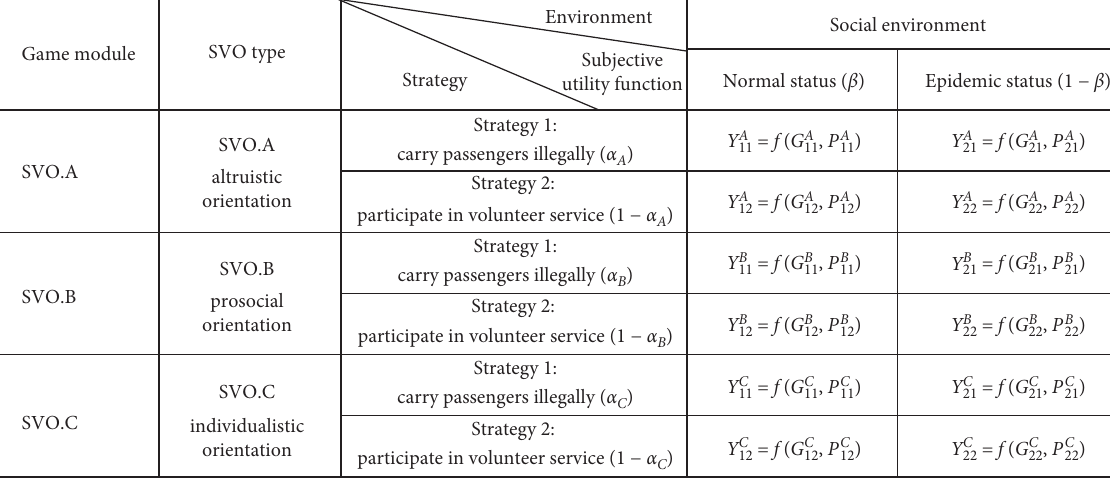
Figure 6: Game modules when SVO type is A, B, and C.